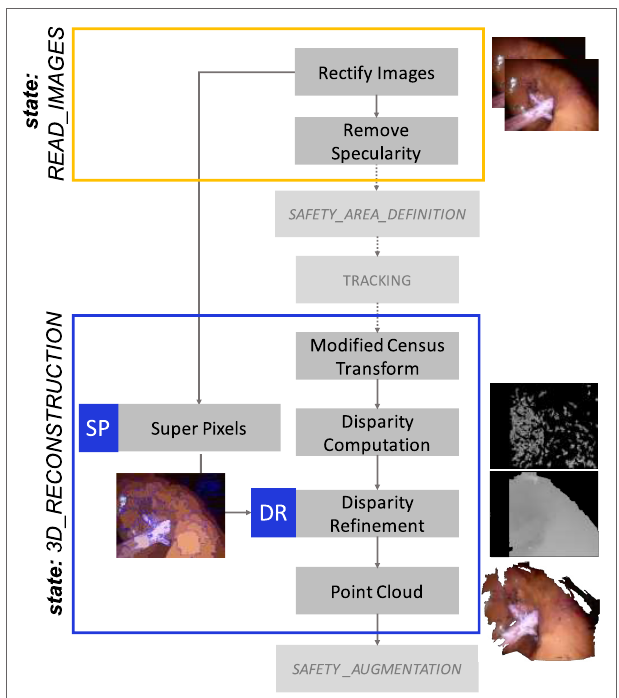
FigUre 6 | 3 D _ RECOSTRUCTION state workflow . A dense 3D reconstruction algorithm is used to retrieve the 3D information of the surface contained in the SA. A modified Census Transform makes the stereo matching more robust to illumination variations. SLIC Super Pixel segmentation algorithm is exploited to refine the disparity map, clustering the valid disparity values depending on the homogeneous areas segmented and replacing the invalid values with the strategy described in Sec.